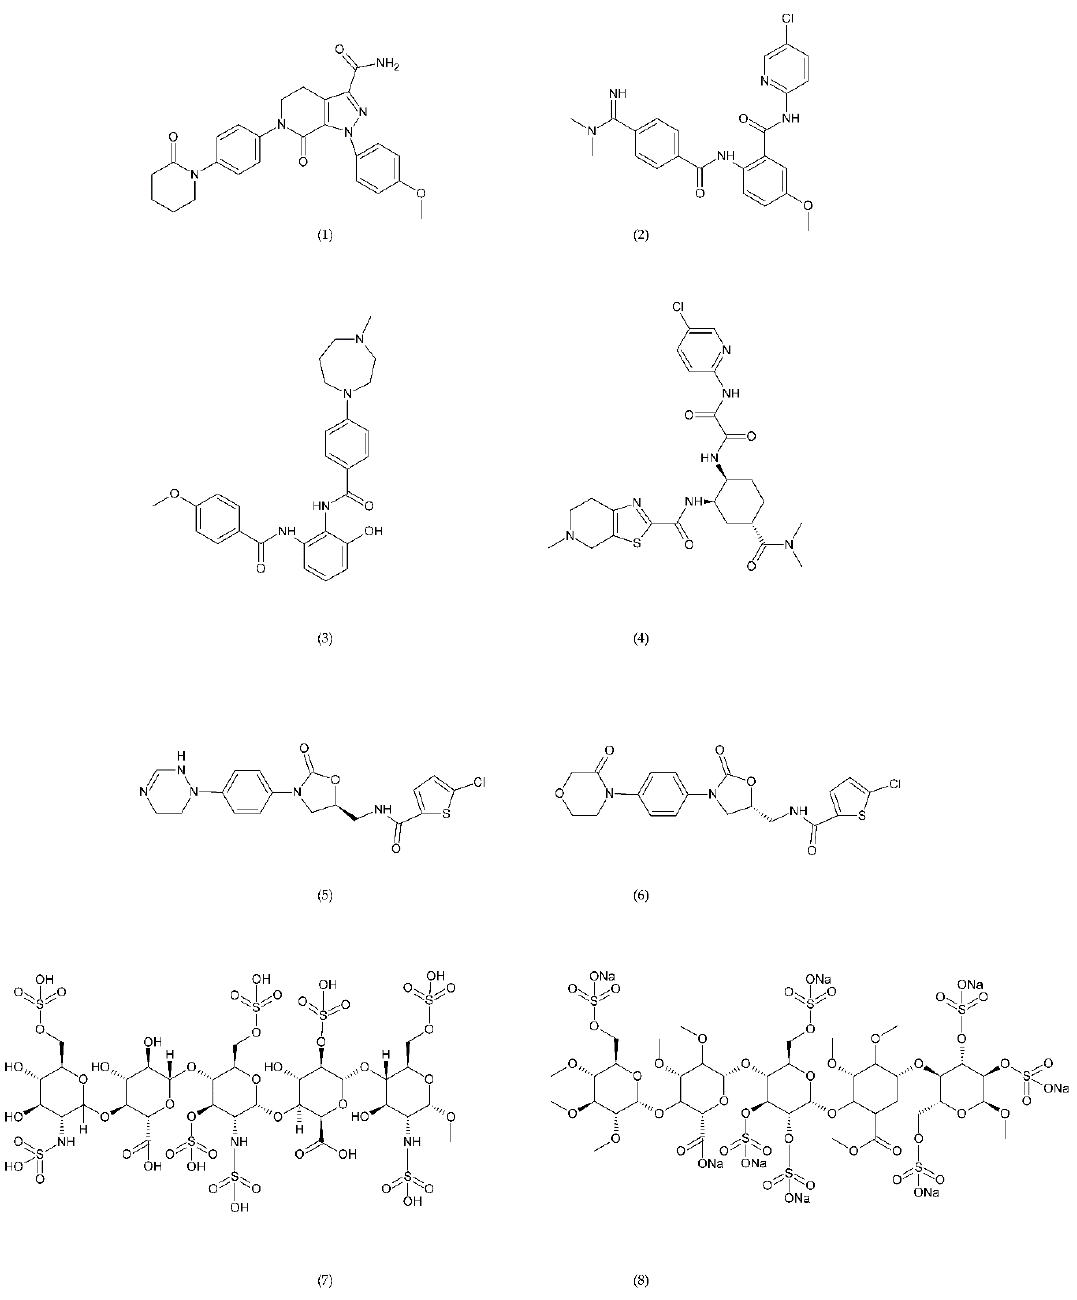
Figure 6. Direct factor Xa inhibitors: apixaban (1), betrixaban (2), darexaban (3), edoxaban (4), nokxaban (5), rivaroxaban (6), fondaparinux (7), and idraparinux (8).